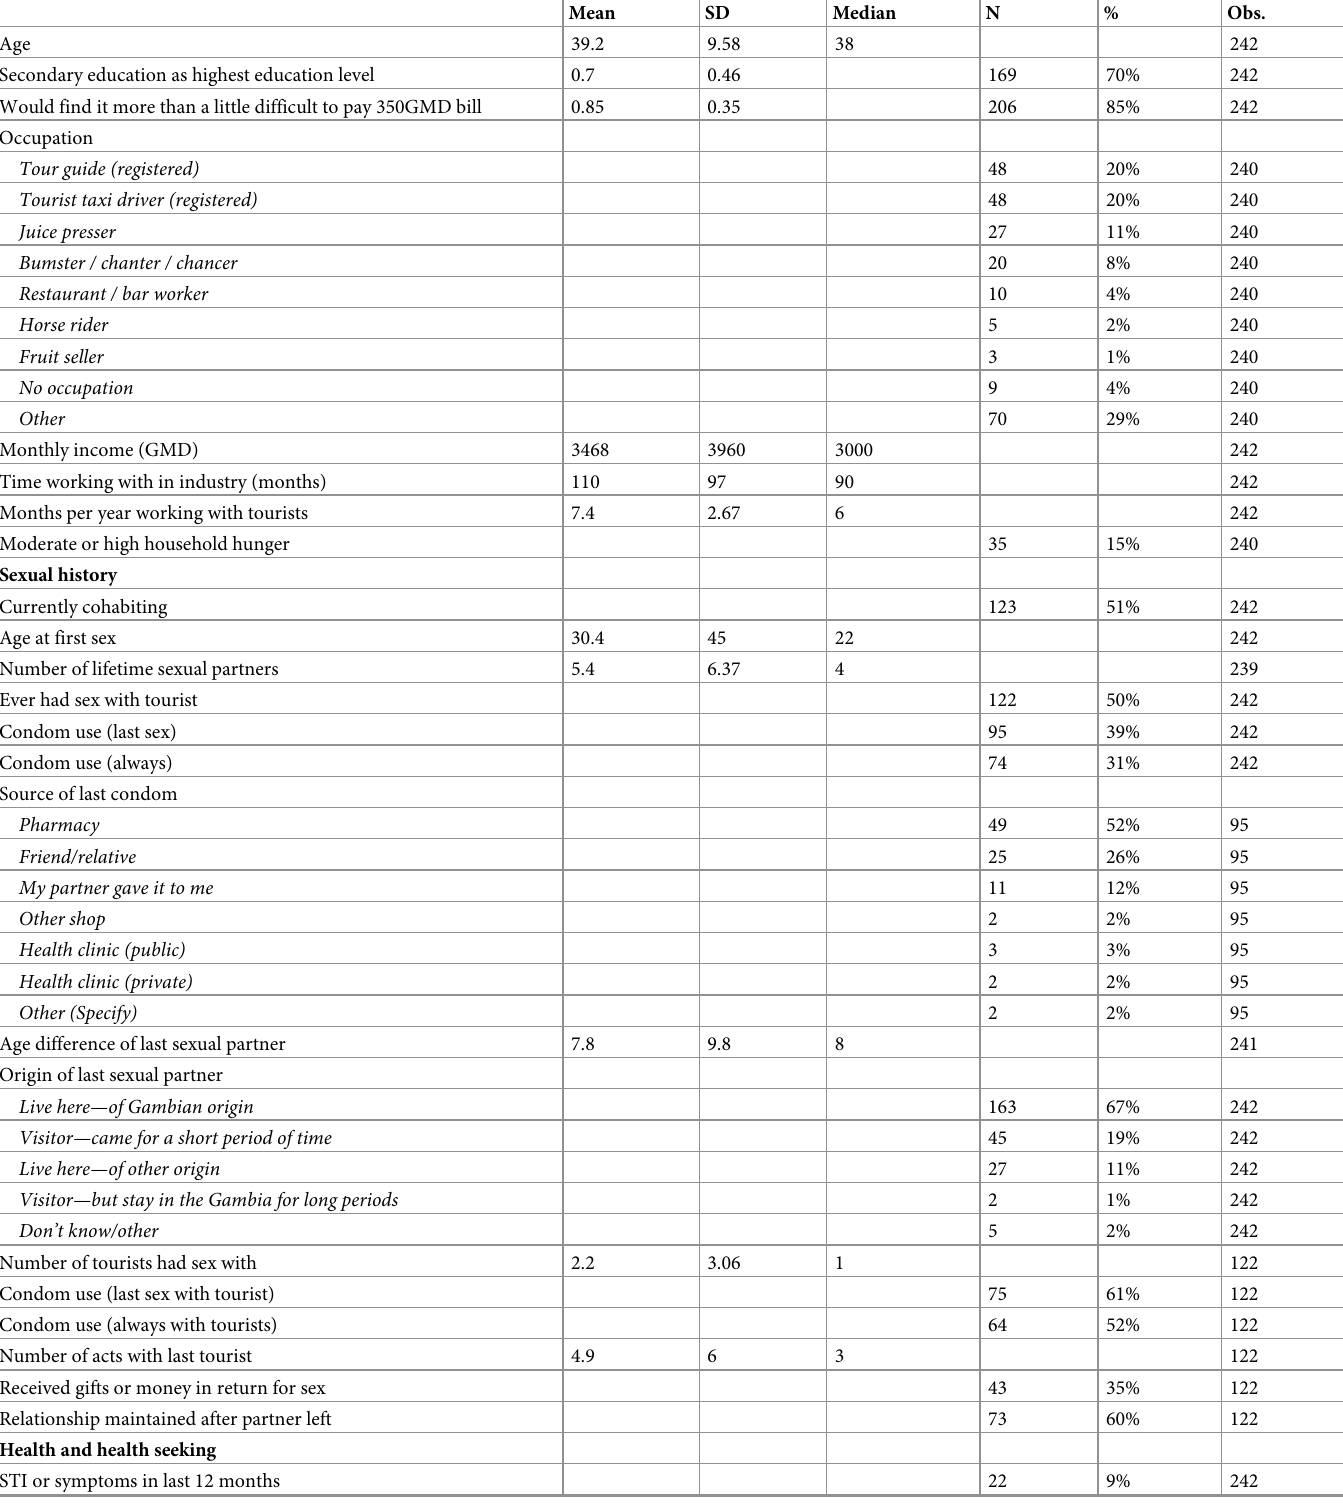
Table 2. Descriptive statistics of quantitative